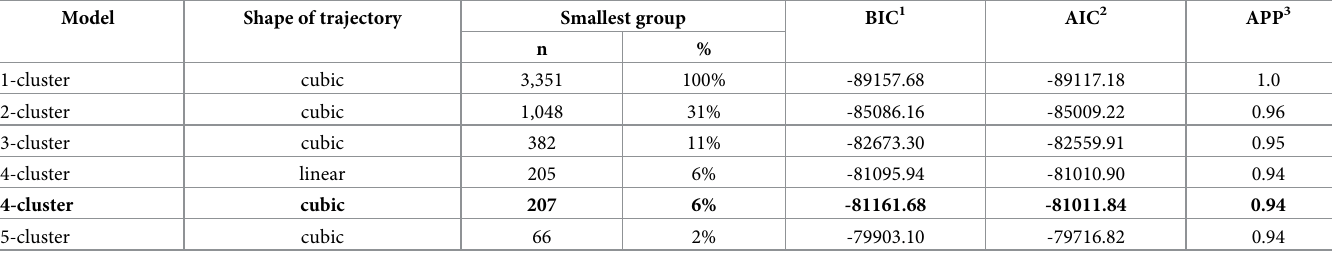
Table 2. Goodness of fit of group-based trajectory analysis models. The chosen model is shown in bold. Model